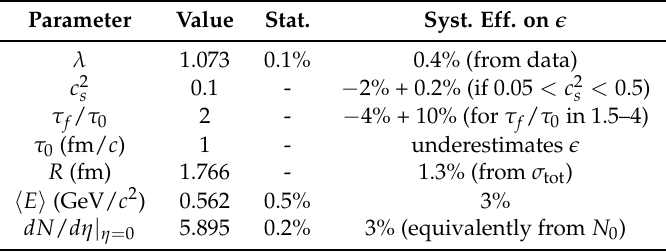
Table 1. Sources of statistical and systematic errors for the 7 TeV estimate.